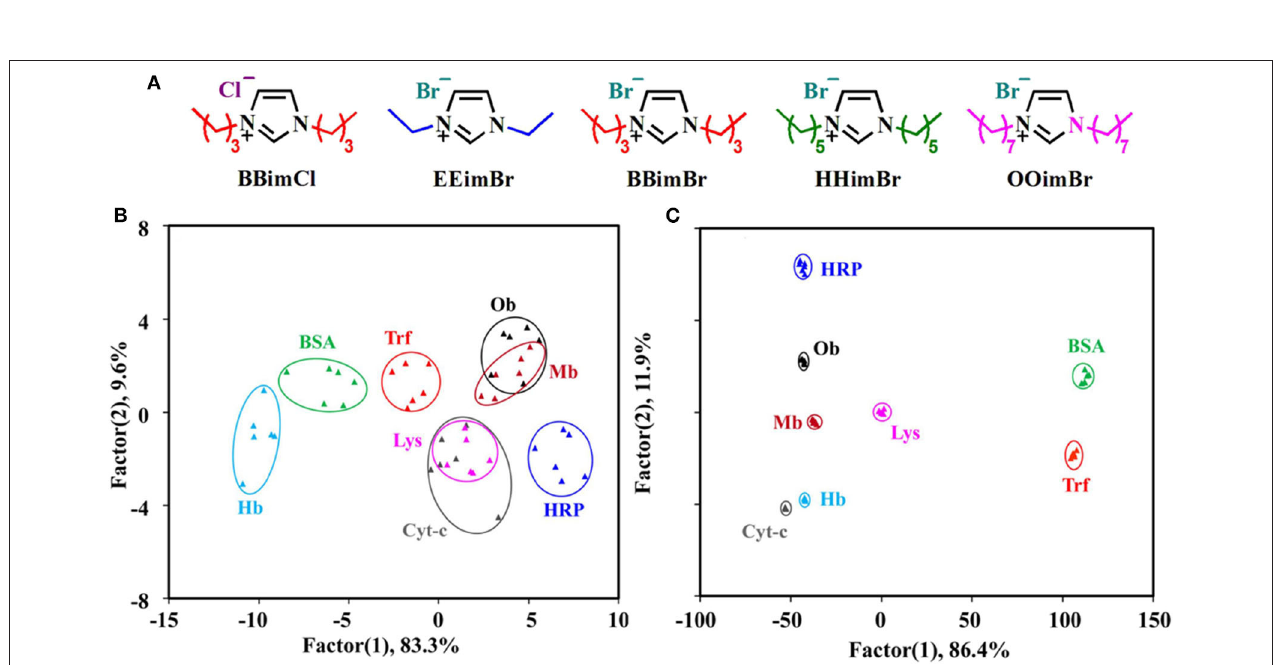
FIGURE 3 | (A) Chemical Structures of five different ionic liquids. Canonical score plots for identifying eight proteins at 500nM based on (B) ionic liquids and (C) ionic liquids-QDs. Reprinted from Chen et al. (2015) with permission.